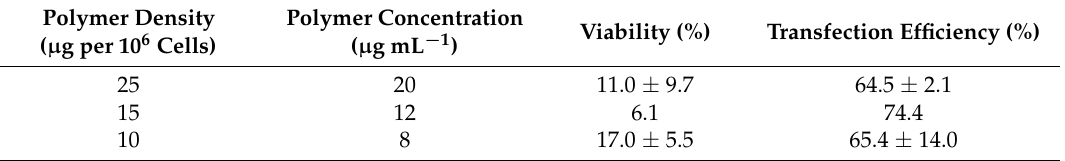
Table 5. Transfection in Eppendorf tubes as a function of the polymer